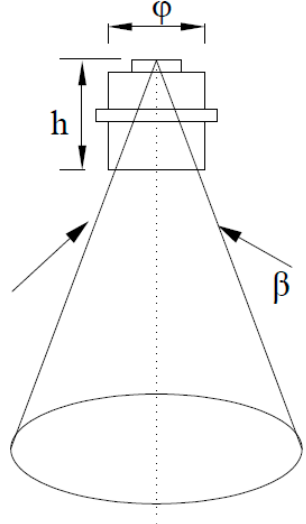
Figure 6. Parameter estimation of detection lenses.